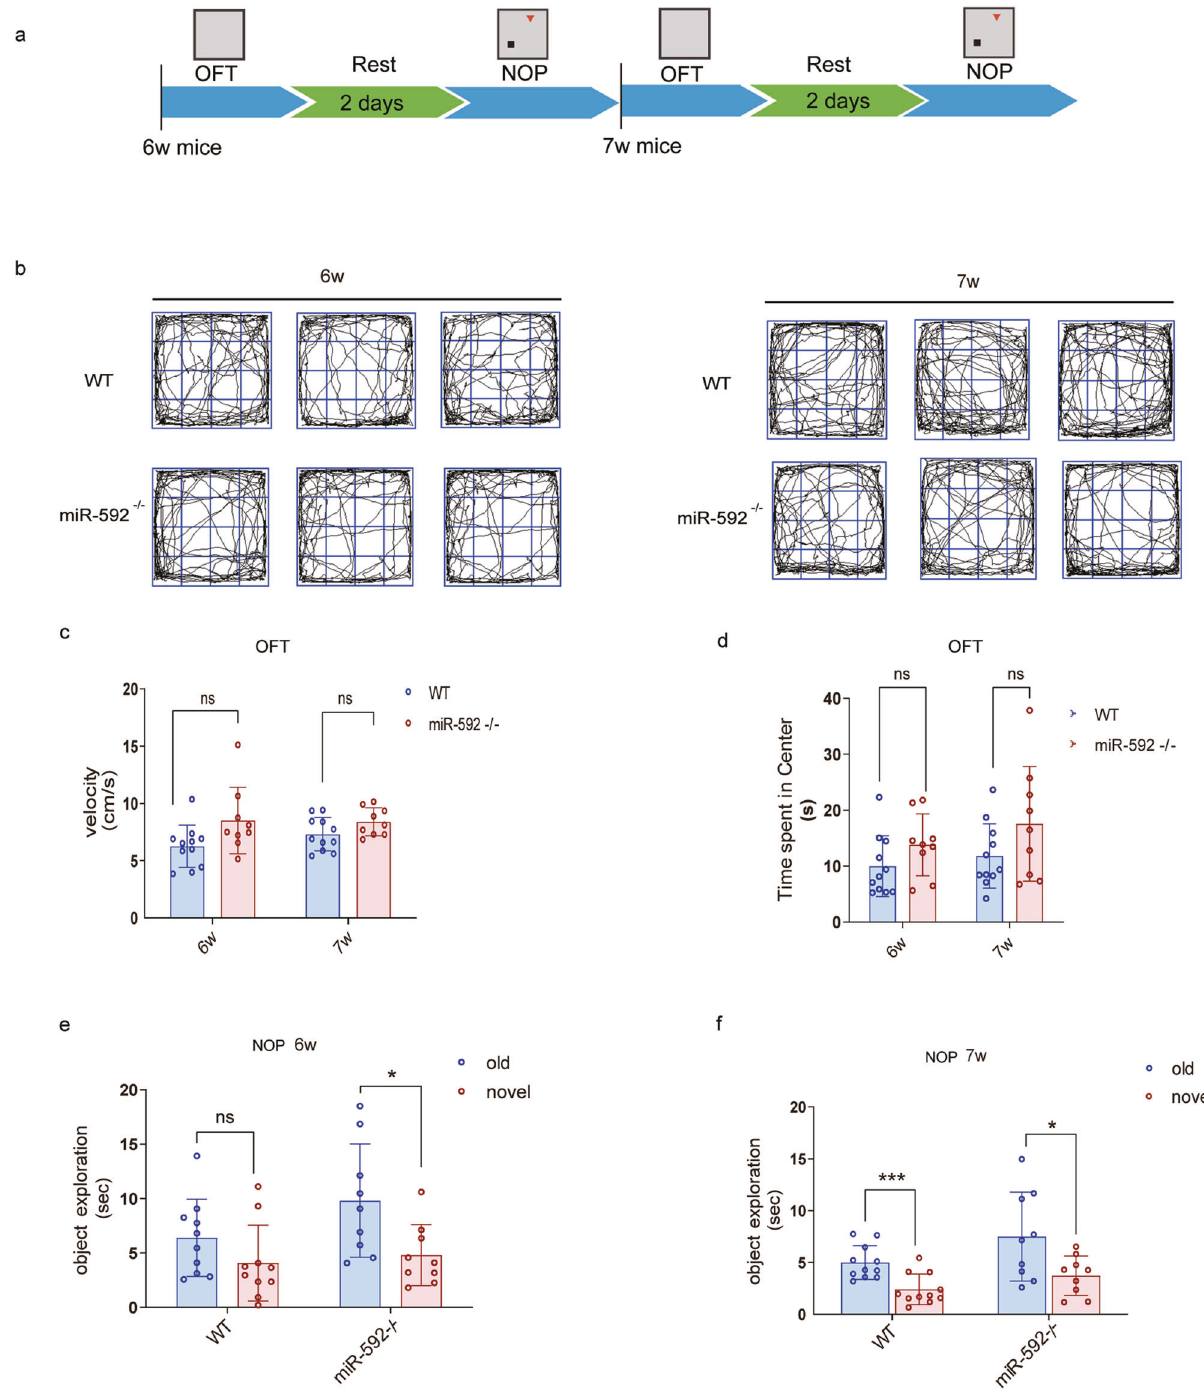
Fig. 7 Genetic deletion of miR-592 reduced social interaction at early stage. a Timeline of younger behavioural tests. b OFT open fi eld test. Representative images showing typical examples of the exploration behaviour of WT and miR-592 − / − mice during the fi rst 5 min of the open fi eld test. 6W: 6 weeks after birth. 7W: 7 weeks after birth. c OFT open fi eld test. The velocity was scored for each 5 min period. 6W: 6 weeks after birth ( n = 8). d The time spent in the centre was scored for each 5 min period. 7W: 7 weeks after birth (one-way ANOVA with Tukey ’ s multiple comparison test, n = 8, error bars represent S.E.M.). e NOP novel object preference test. The curiosity behaviour was performed to test the social novelty of WT and miR-592 − / − mice at the sixth week. 6W: 6 weeks after birth (two-way ANOVA with Tukey ’ s multiple comparison test, n = 8, error bars represent S.E.M.). f NOP novel object preference test. The curiosity behaviour was performed to test the social novelty of WT and miR-592 − / − mice at the seventh week. 7W: 7 weeks after birth (two-way ANOVA with Tukey ’ s multiple comparison test, n = 8, error bars represent S.E.M.). * p < 0.05, *** p < 0.001.